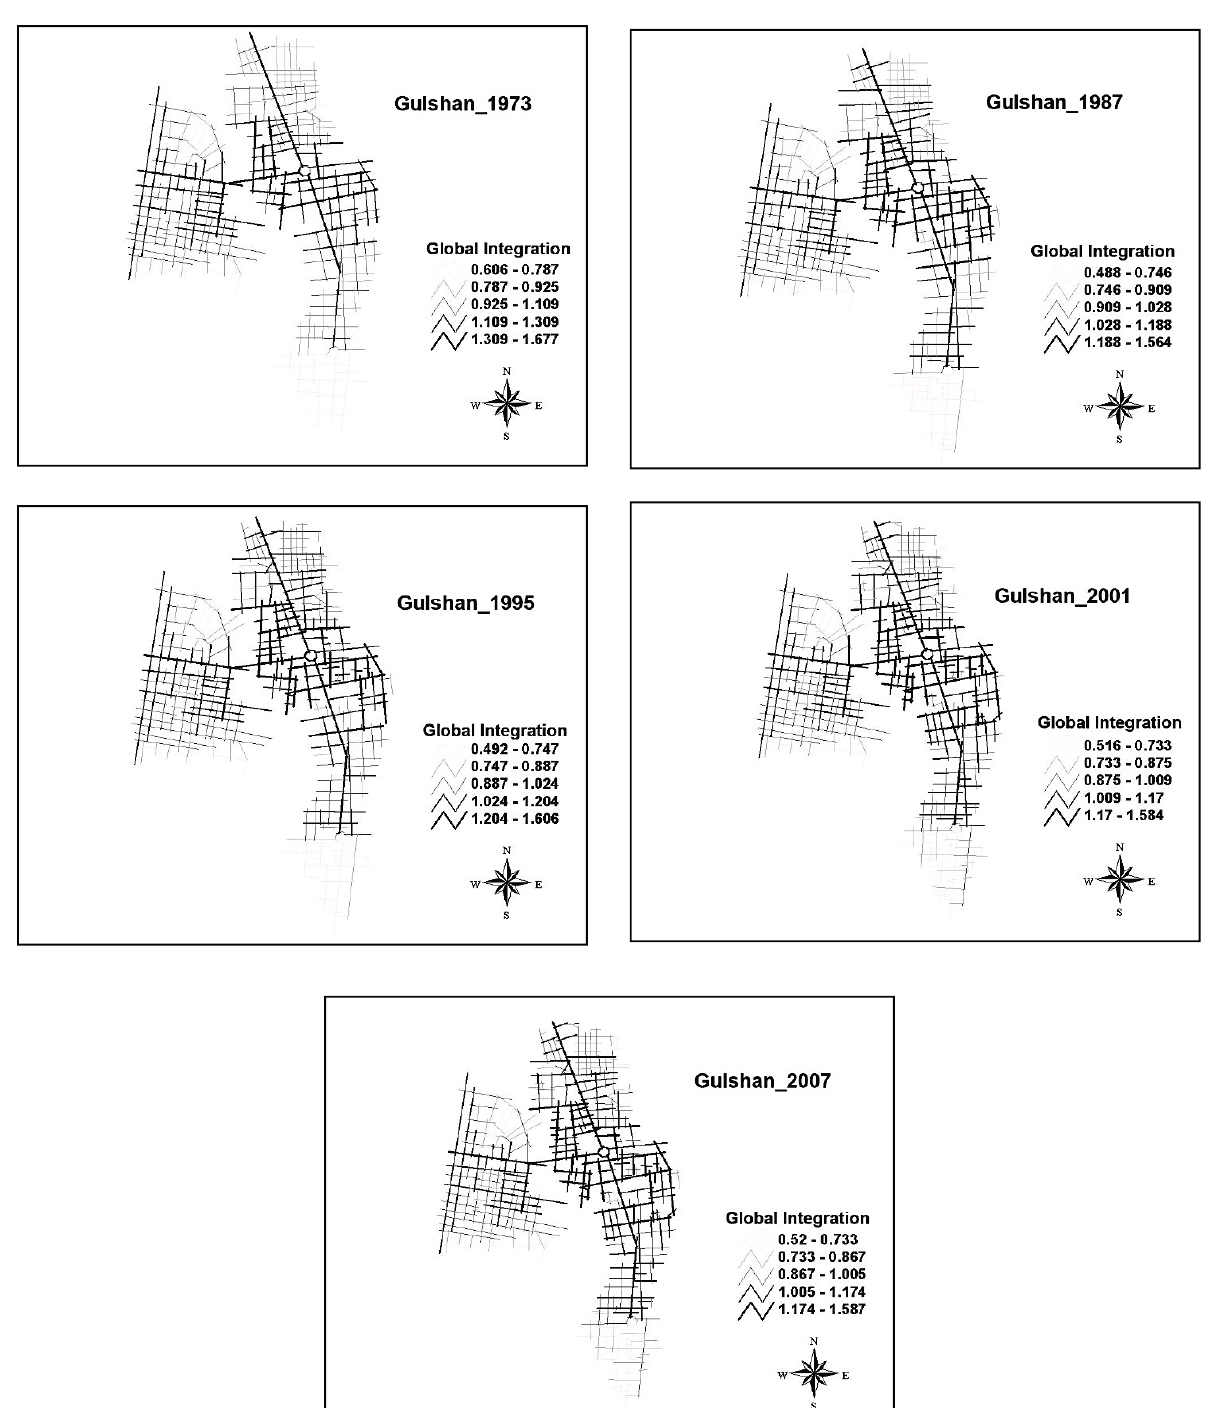
Figure 7. Global integration (R = n ) maps of ward 19 (Gulshan) in different time periods (not to